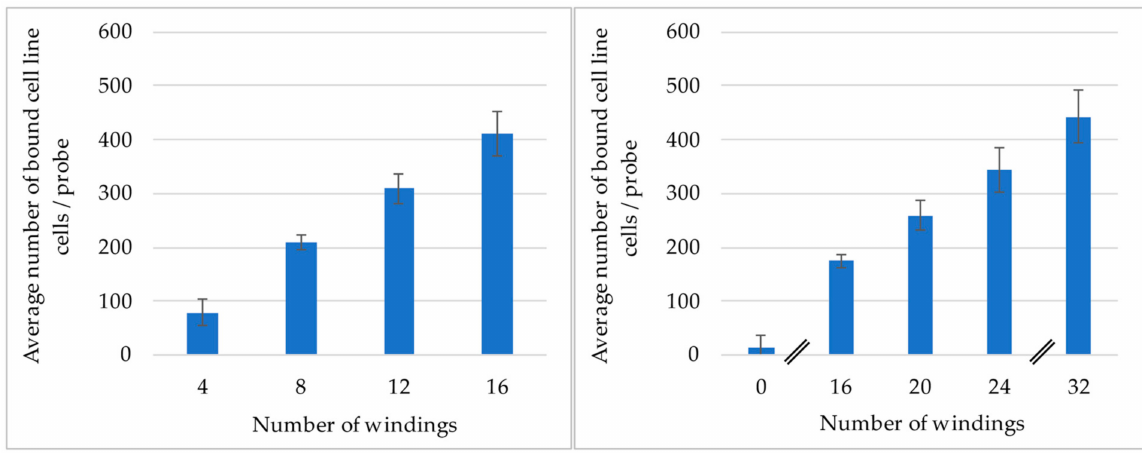
Figure 6. ( Left ), shows the cell binding efficiency using the LNCaP cell line and anti-EpCAM coating for the lower number of windings (N = 7). ( Right ), shows the cell binding efficiency for the HUVEC cell line and anti-CD 105 coating for the higher number of windings and for zero windings (N = 4).